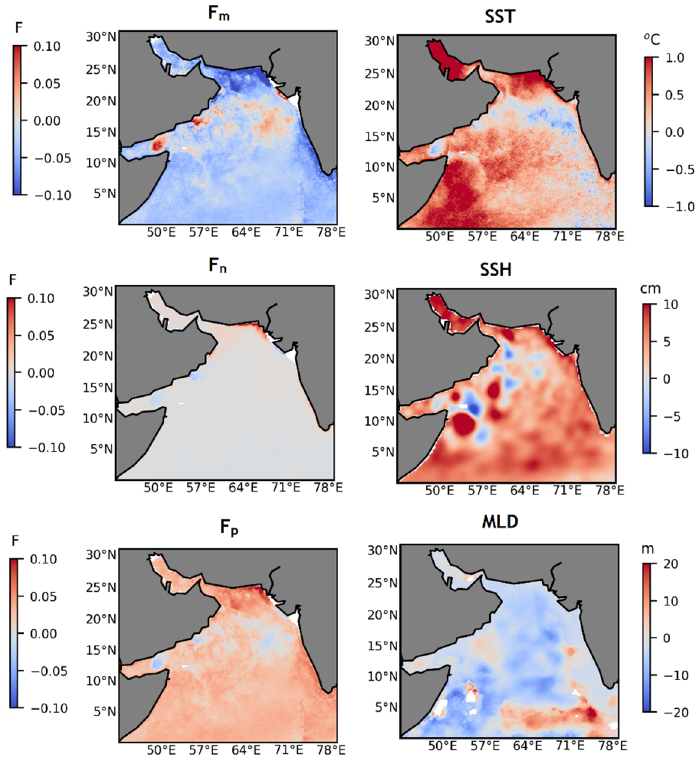
Figure 10. Monthly anomaly F m , F n , F p , SST, SSH and MLD during the extreme positive IOD (October 2019) in the Arabian Sea.